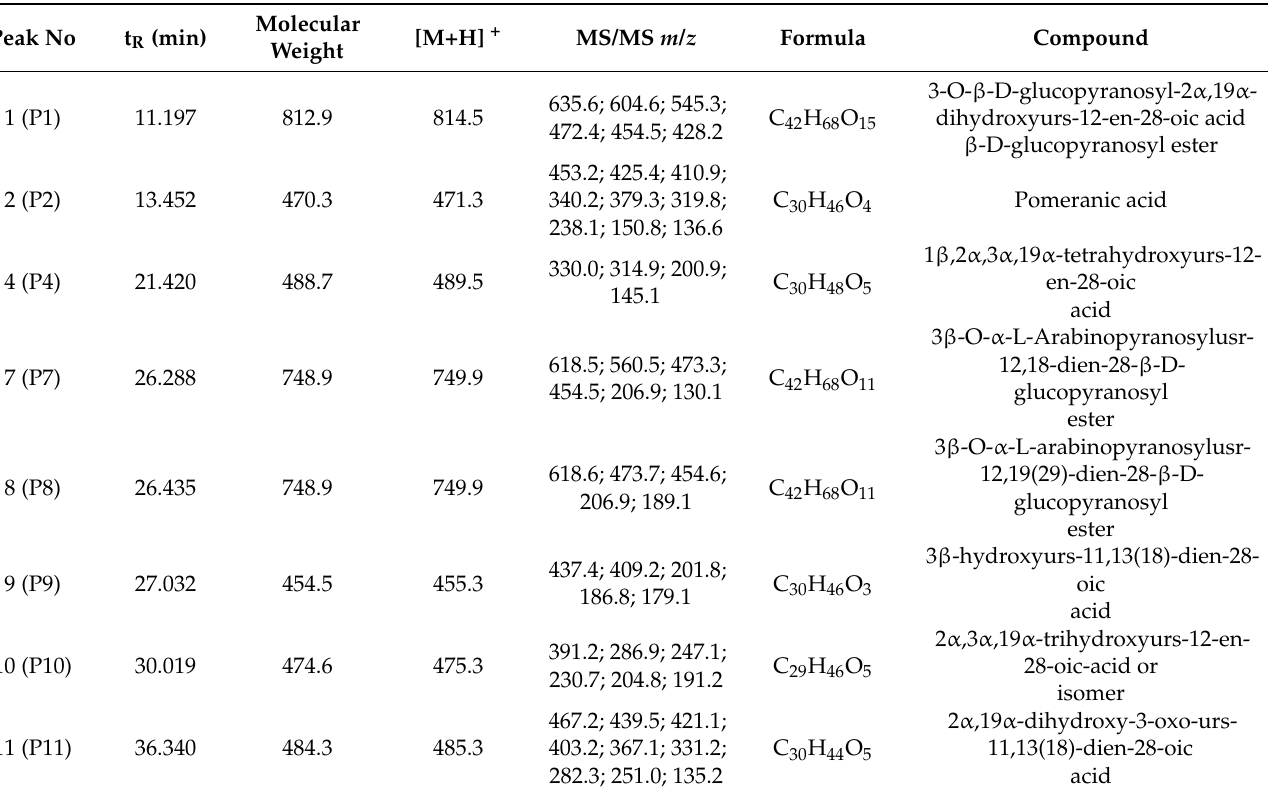
Table 2. Fragment ions of the common components in Sanguisorba officinalis L. before and after processing (UHPLC-ESI + -MS/MS).